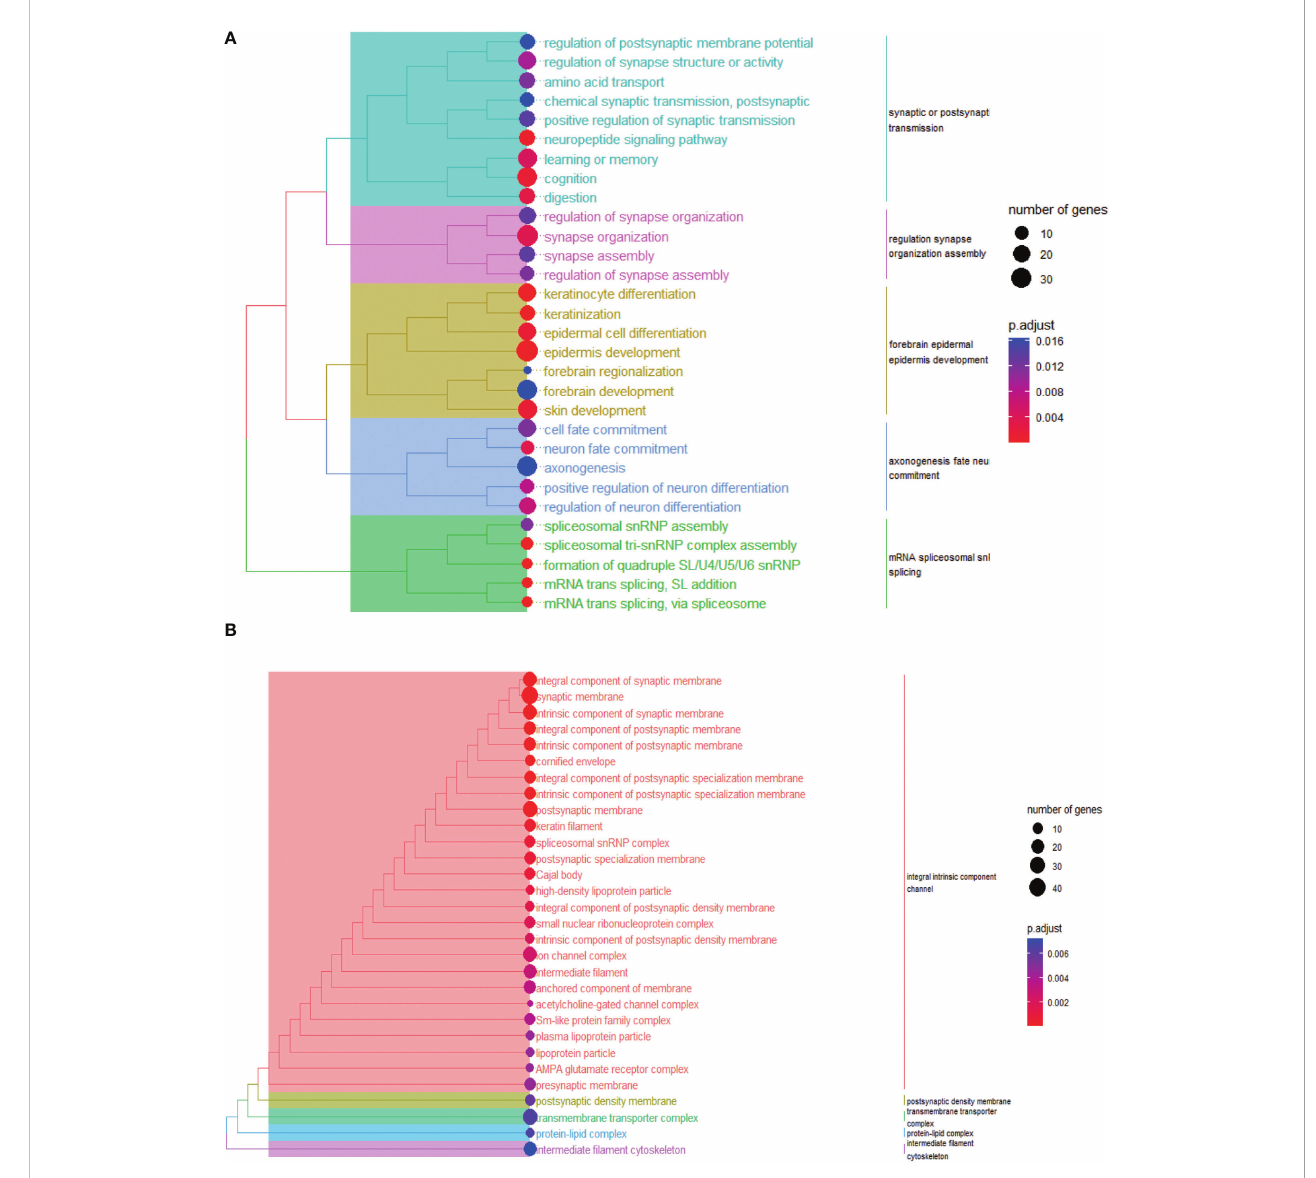
FIGURE 5 Biological process (A) and cellular component (B) enrichment analyses of differential genes between low-risk group and high-risk